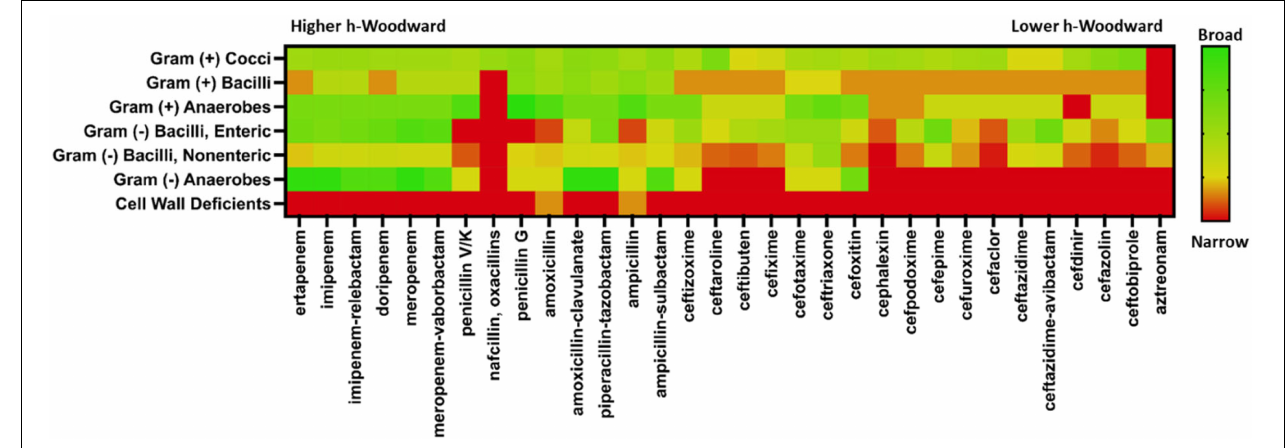
FIGURE 6 | Antimicrobial spectra of β -lactams. Clinical activity data were taken from The Stanford Guide to Antimicrobial Therapy. A fractional coverage index was calculated using a weighted average of categorical coverage values reported. Heatmap color range is from green indicating high coverage and red indicating low coverage. Beta-lactams are ordered from highest h -Woodward value (ertapenem) to lowest